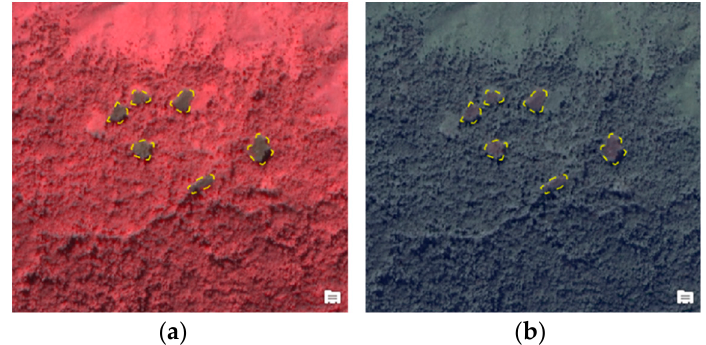
Figure 9. Illustrations of the different band combinations: ( a ) NRG combination image and ( b ) RGB combination image. Yellow dotted lines indicate the target parcels.